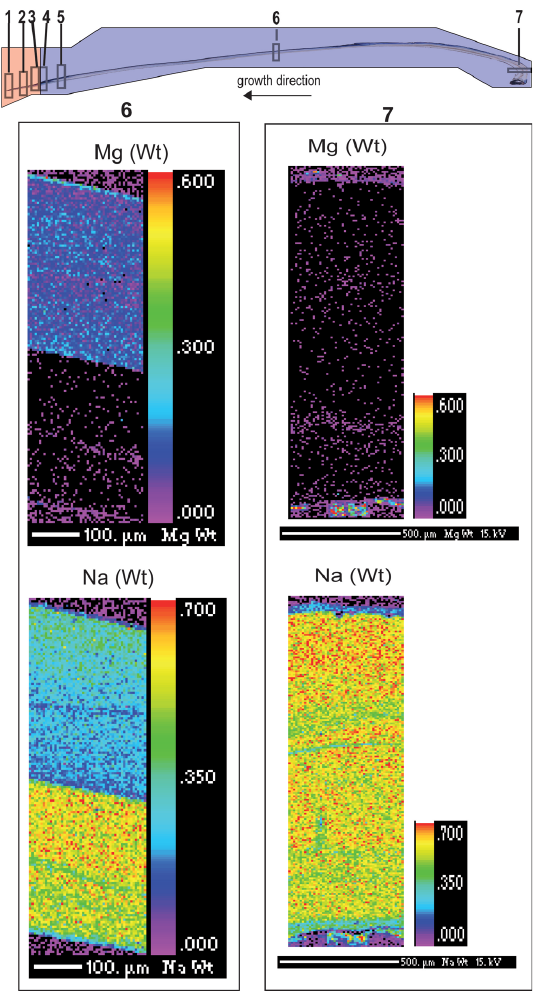
Fig. 8. Thin section view of M. galloprovincialis from acidified ex- perimental site B1. Blue colour indicates shell precipitated prior to transplantation and red colour indicates shell precipitated after transplantation to acidified test site. Gray boxes numbered 1 to 7 indicate the position of the microprobe maps. The maps 1 to 5 are shown in Fig. 7. Magnesium and sodium concentration is given in weight percent. Differences in element concentrations in map 6 re- flect differences between calcite and aragonite layer. Magnesium and sodium are incorporated in calcite layer. Nacreous layer dis- plays considerably higher concentrations of sodium. Judging from elemental maps, the shell hinge is composed almost entirely of arag-